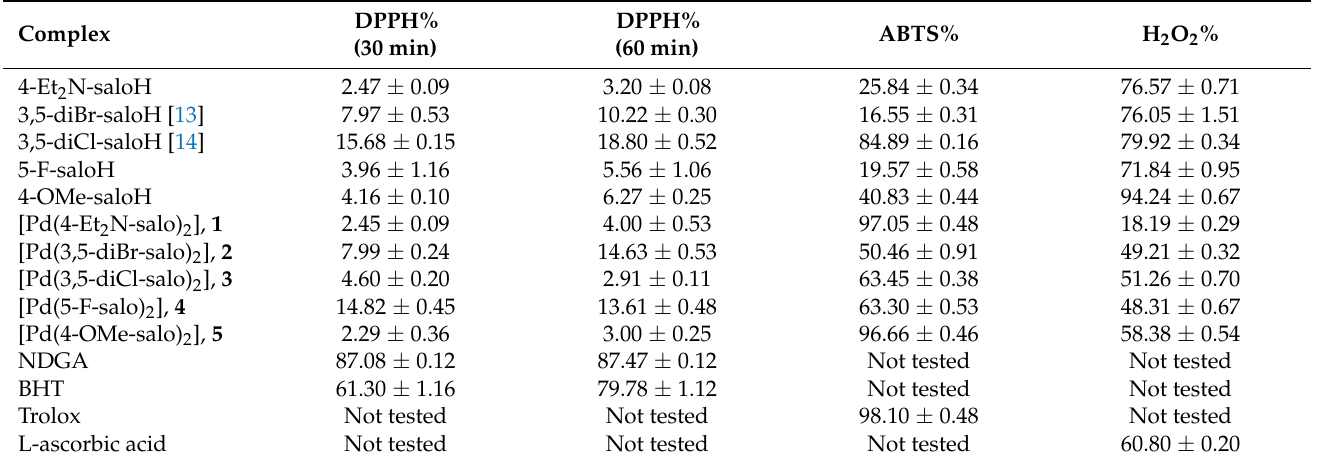
Table 1. % DPPH-scavenging ability (DPPH%), % ABTS-scavenging activity (ABTS%), and H 2 O 2 - reducing activity (H 2 O 2 %) for X-saloH and complexes 1 – 5